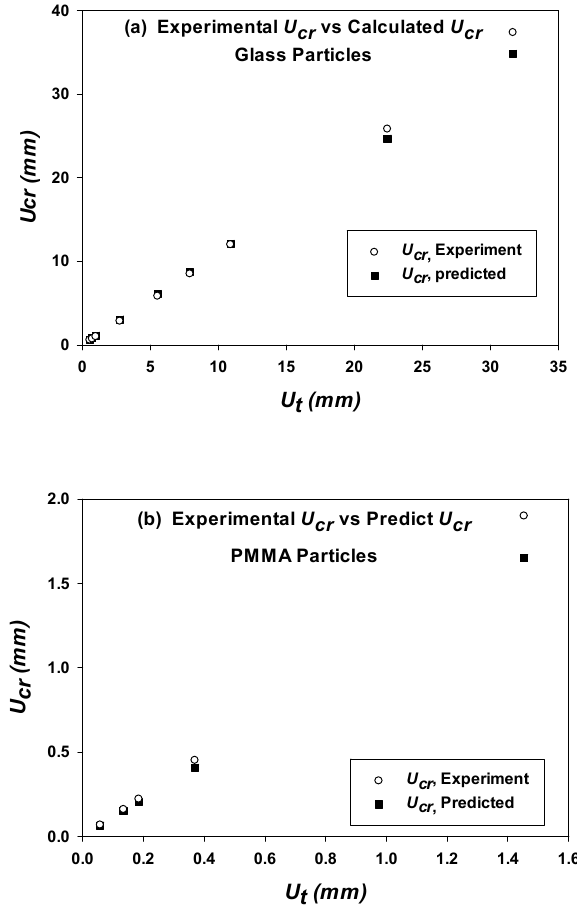
Figure 9. Experimental critical transition velocity and predicted critical transition velocity as a function of particle terminal velocity for ( a ) glass particles and ( b ) polymethyl methacrylate (PMMA) particles.